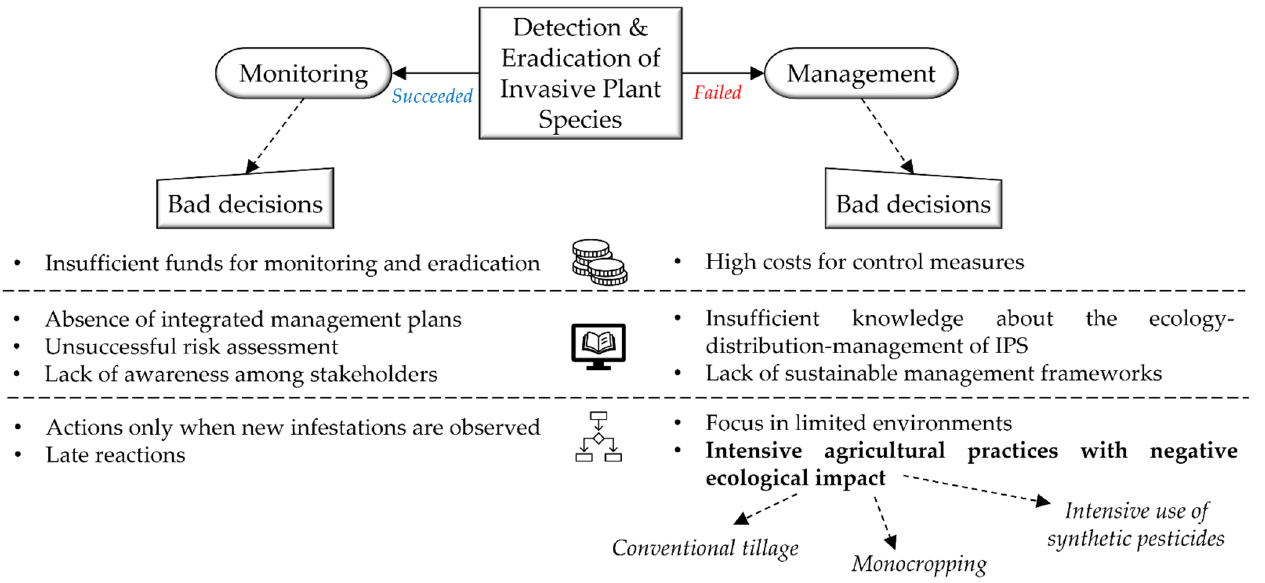
Figure 1. A conceptual framework of the decision-making process for the monitoring and manage- ment of invasive plant species.